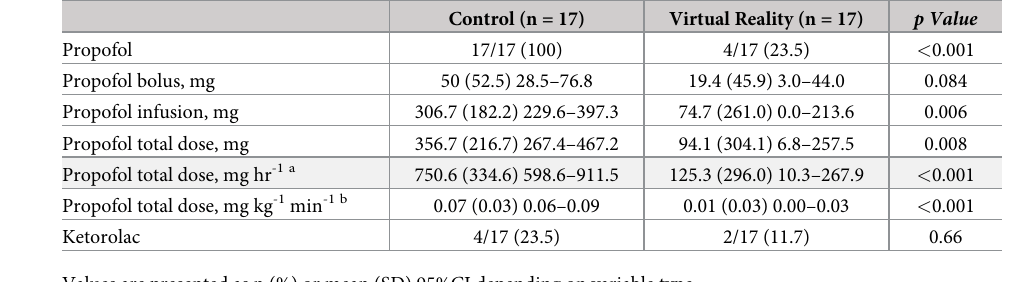
There were no significant differences found between groups with regards to perioperative opi- oid analgesics administered or PACU pain scores. Intraoperative airway and respiration com- ments were documented in 14/17 and 15/17 patients in the VR and control groups, respectively. Respirations were characterized as normal with no need for assistance in 13/17 patients in both groups. One patient in the VR group required an oral airway, and one patient in the control group required a nasal trumpet for upper airway obstruction. PACU LOS was significantly decreased in the VR group compared to the control group (Median (IQR) VR 53.0 (43.0–72.0) vs control 75.0 (57.5–89.0) min, p = 0.018) (Table 3, Fig 3). No exploratory analyses were performed on this data. No unintended harm or effects occurred in either group during the study. Table 2. Intraoperative anesthetics administered by group.